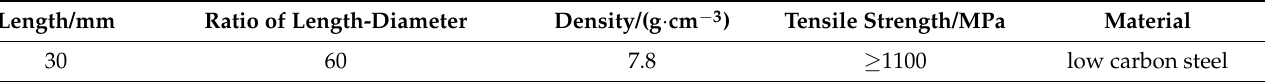
Table 4. Physical properties of steel fiber.